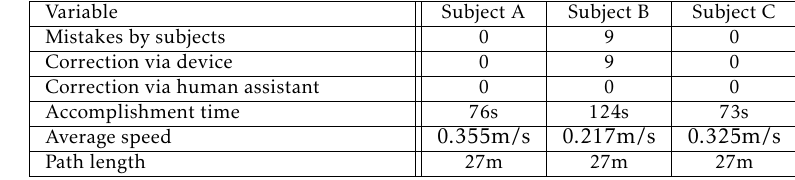
Table 2. The relevant descriptive statistics and factors are measured for three student subjects in walking experiment.